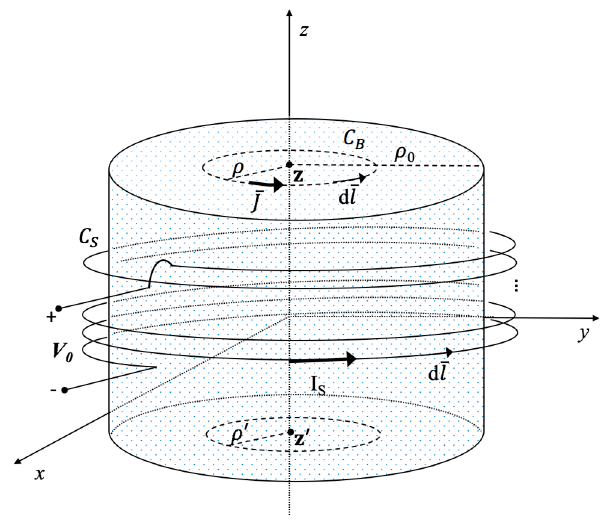
Figure 1. Schematic representation of the sensor coil wrapped around the body, represented by the cylindrical structure.